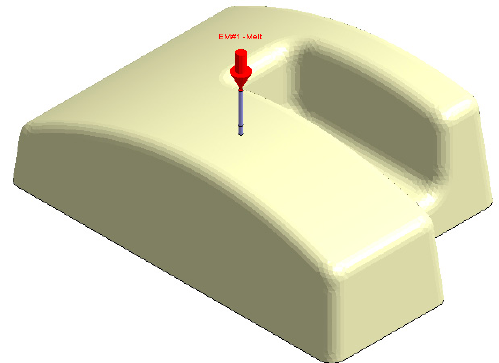
Figure 32. Plastic part, Case D.